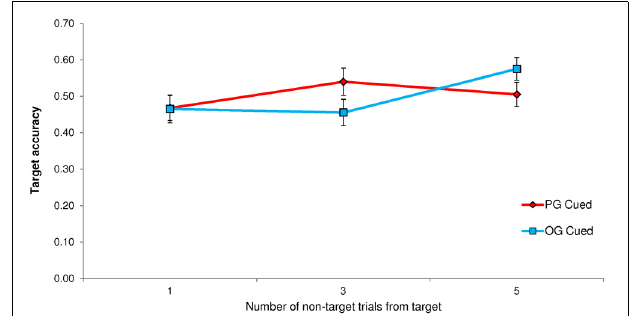
FIGURE 7 | Experiment 4 accuracy rates in the Sustained Attention to Response Task following personal-goal (PG) cues and other-goal (OG) cues, presented either 1, 3, or 5 non-target trials preceding the target and thought probe.